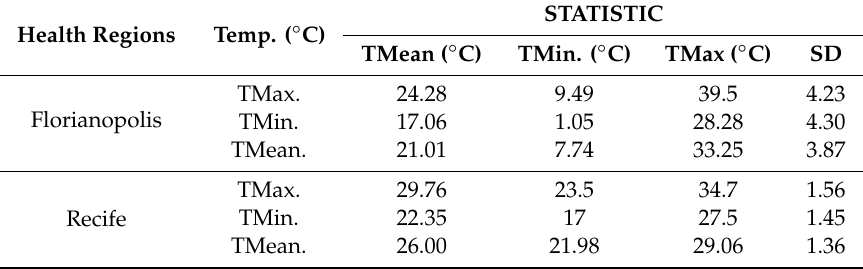
Table 1. Statistical analysis (mean, minimum, maximum, and standard deviation (SD)) of the mean (TMean.), maximum(TMax.), andminimum(TMin.) temperaturesforthehealthregionsofFlorian ó polis, SC and Recife, PE between the years